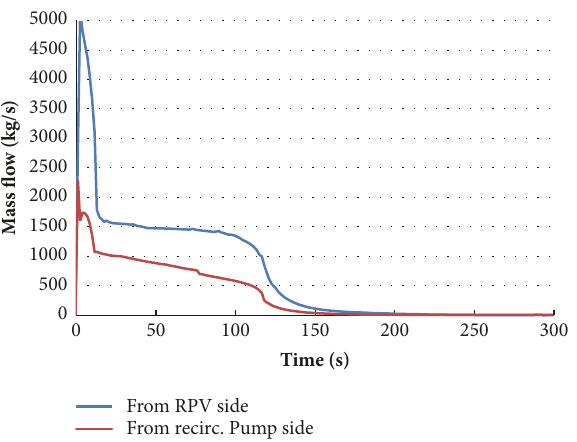
Figure 4: Waterdischarge flow ratethrough the break (both ends of the pipe).